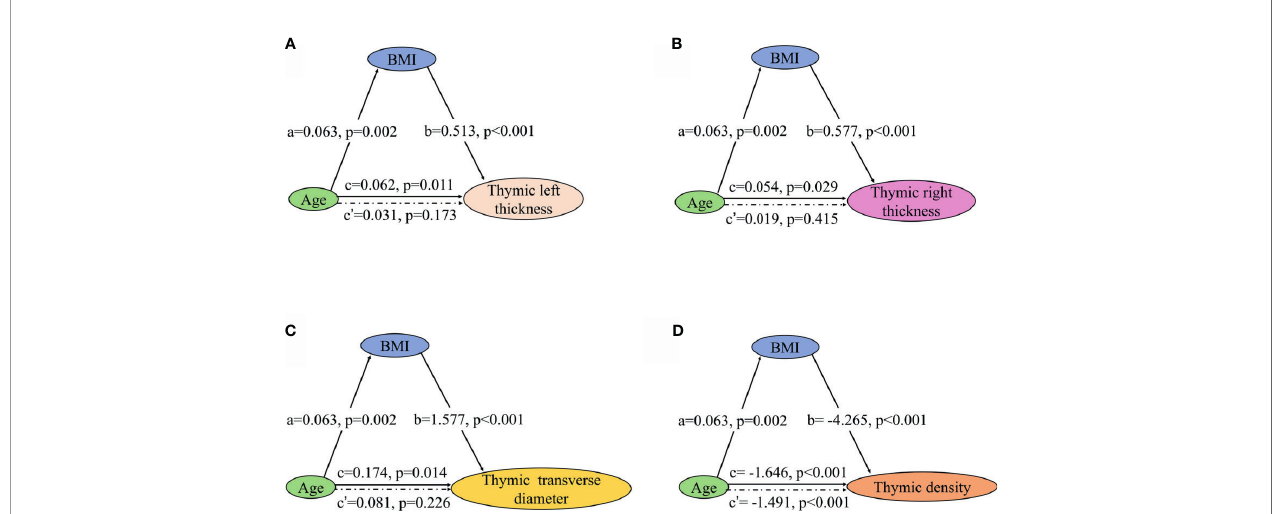
FIGURE 6 | Mediation effects of changes in BMI on the association of increase in thymic predominant sides with age and decline in thymic density with age. (A – C) Mediation analysis was performed to examine the potential indirect relationship between Age (X) and thymic predominant sides (Y) via the BMI (M). (D) Mediation analysis the potential indirect relationship between Age (X) and thymic density (Y) via the BMI (M). Path a and path b indicate the association between X and M, and M and Y, respectively. Path c represents the total effect of X on Y, and path c ’ shows the direct effect of X on Y after controlling for mediating factor. X, predictor variable; Y, outcome variable; M, mediator; BMI, body mass index.